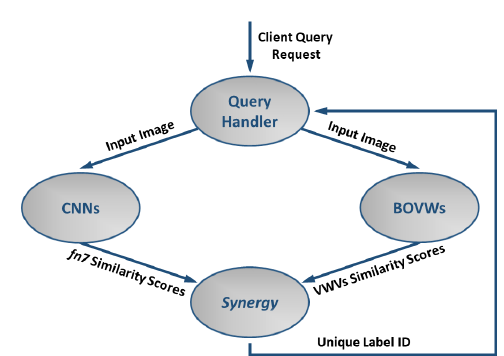
Figure 5. Block diagram of the content recognition module’s information